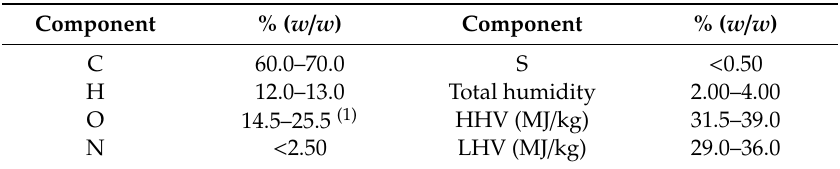
Table 2. Elemental composition, humidity and heating values of cork / eucalyptus liquified biomass samples.